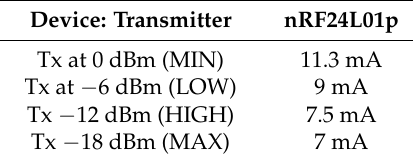
Table 5. Features of nRF24L01p transmitter